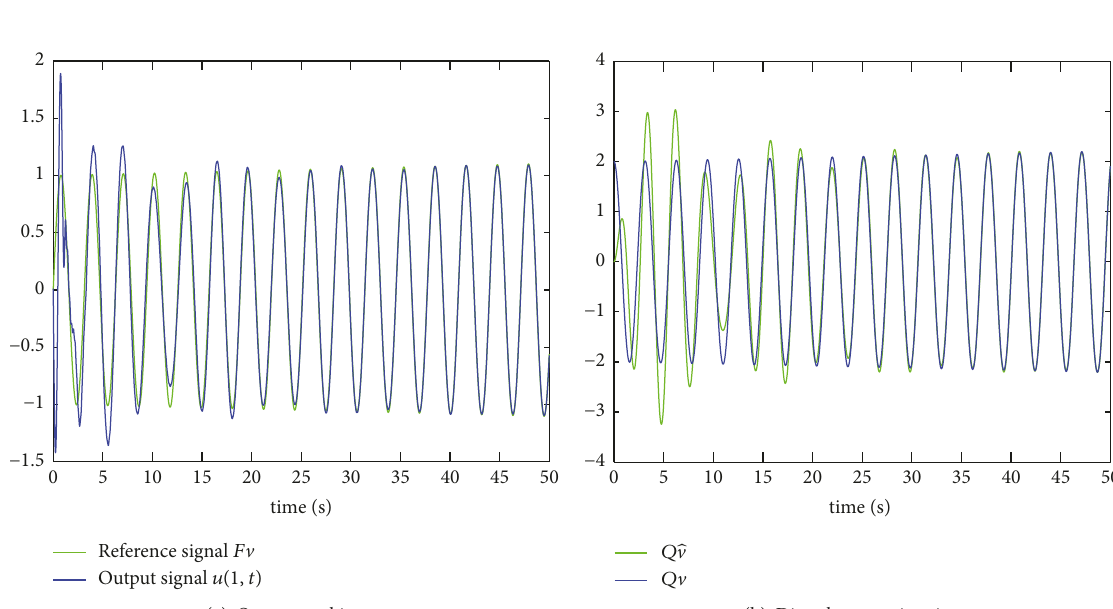
Figure 2: Output tracking and disturbance